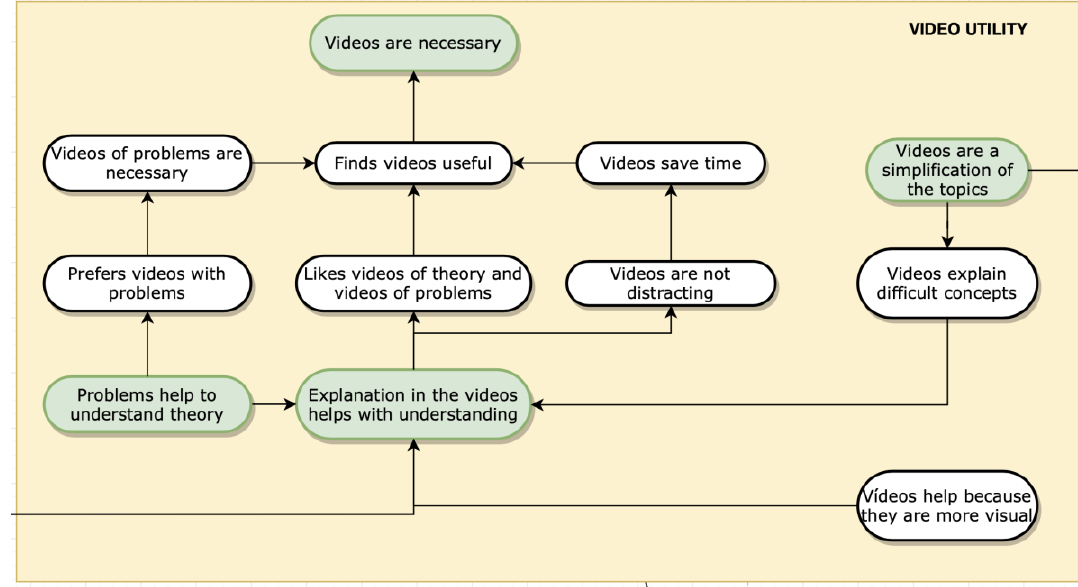
Figure 4. Enlargement of the box “ video utility. ”